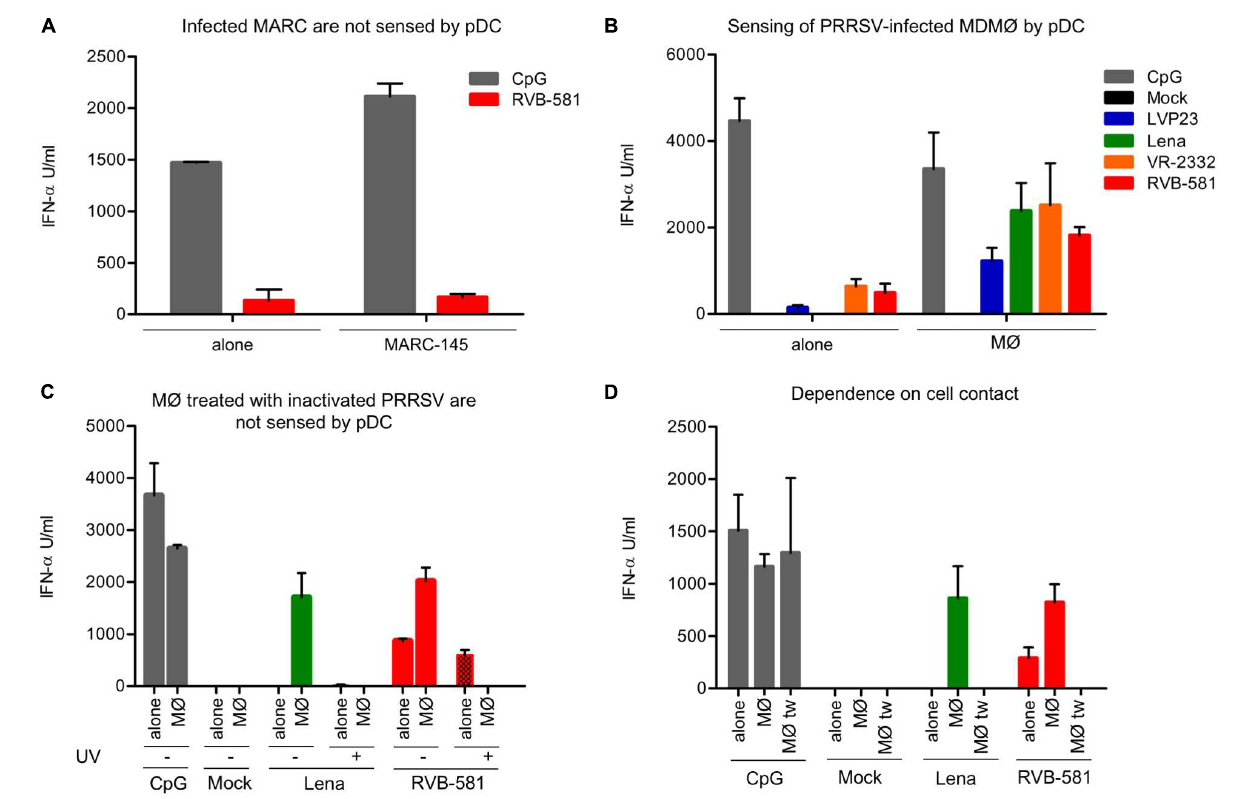
FIGURE 2 | Porcine reproductive and respiratory syndrome virus-infected MØ are strong inducers of IFN- α production by pDC. (A) RVB-581-infected MARC-145 cells do not induce a stronger IFN- α secretion by pDC compared with the free viral particles effect on enriched pDC alone. MARC-145 cells were infected with RVB-581 for 90 min, washed and then co-cultured with enriched pDC. Stimulation of pDC by PRRSV virions (MOI 0.1 TCID 50 /cell) was used as control. (B) PRRSV-infected MØ are more potent activators of pDC as compared to virions (“alone”). Infection of cells was performed as in (A) using four different strains. (C) Stimulation of pDC by infected MØ but not by virions requires live virus. pDC were stimulated either with virions (“alone,” live or inactivated [UV]) or with infected MØ (“MØ”) as described in (A) . (D) pDC cultured in inserts of trans-well plates were either stimulated with virions (“alone”), by contact with infected MØ (“MØ”) or were physically separated from the infected MØ (“MØ tw”). CpG D32 was used as a control for strong pDC activation. All data are the result of experiments performed in triplicate with 20 h of stimulation, with error bars representing the standard deviation. The figures are representative of three (A,B) and two (C,D) different